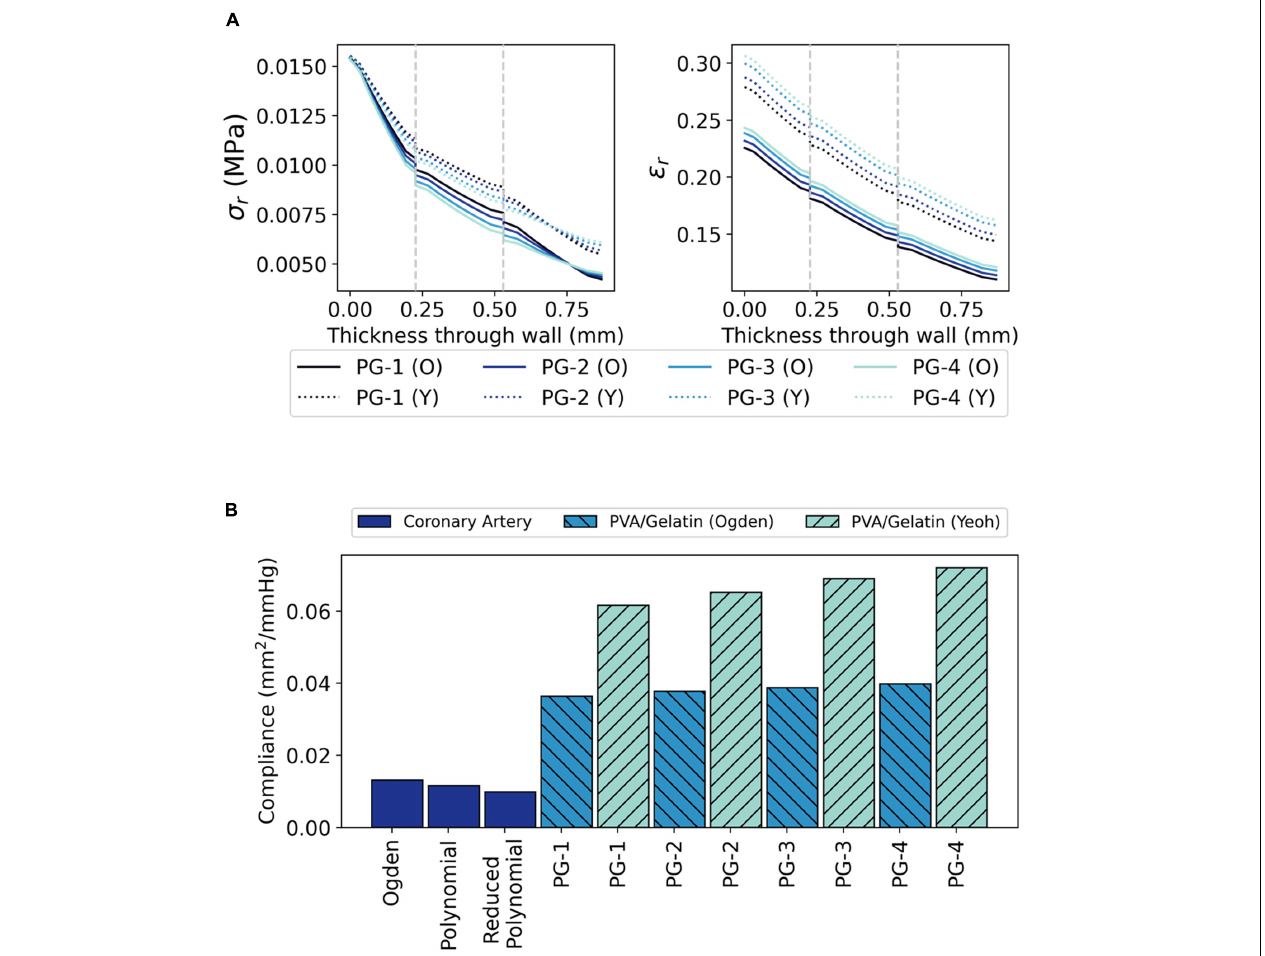
FIGURE 7 | The radial biomechanics of PVA/gelatin grafts at systolic pressure. (A) σ r and (cid:101) r profiles through the radial thickness of each PVA/gelatin graft modelled using Ogden (solid lines) and Yeoh (dashed lines) hyperelastic parameters. Grey dashed lines represent the intima–media and media–adventitia interfaces; (B) Compliance of PVA/gelatin grafts compared to coronary artery